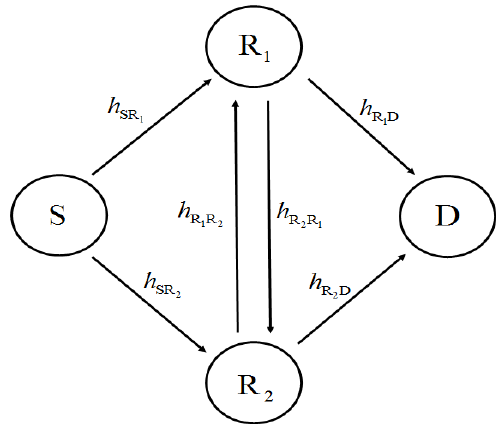
Figure 1. The conventional two ‐ path relay system. Table 1. The configuration for transmission symbols of conventional scheme.